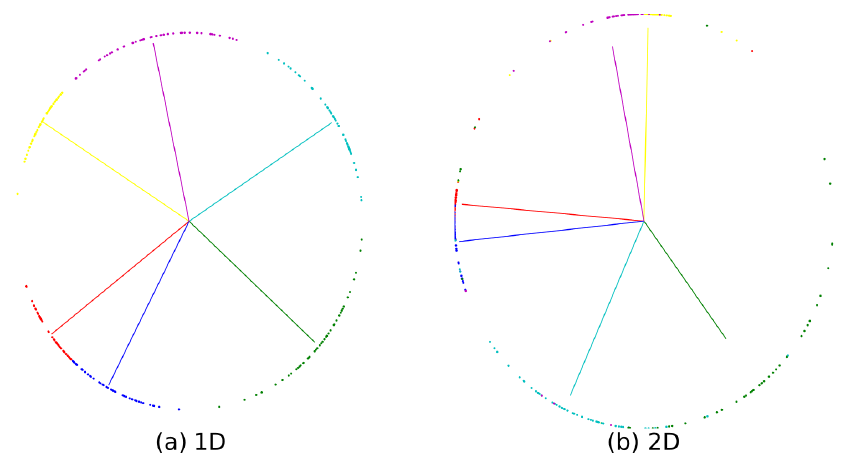
Figure 16. Experiment results on dataset VPN2016 used 1D convolution and 2D convolution. The interval of each point represents the interval between